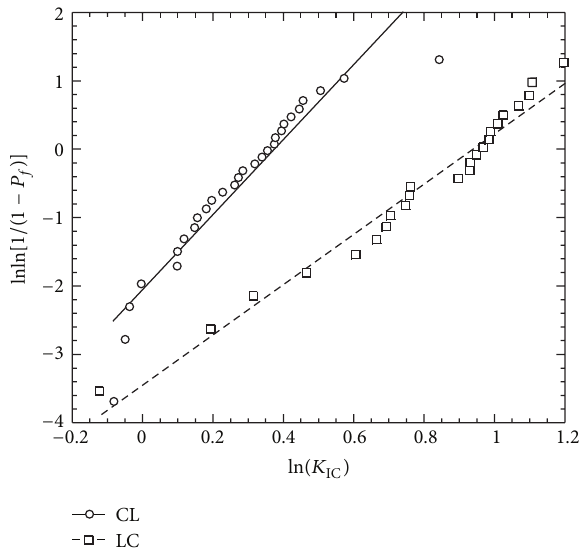
Figure 4: Weibull plots of fracture toughness.